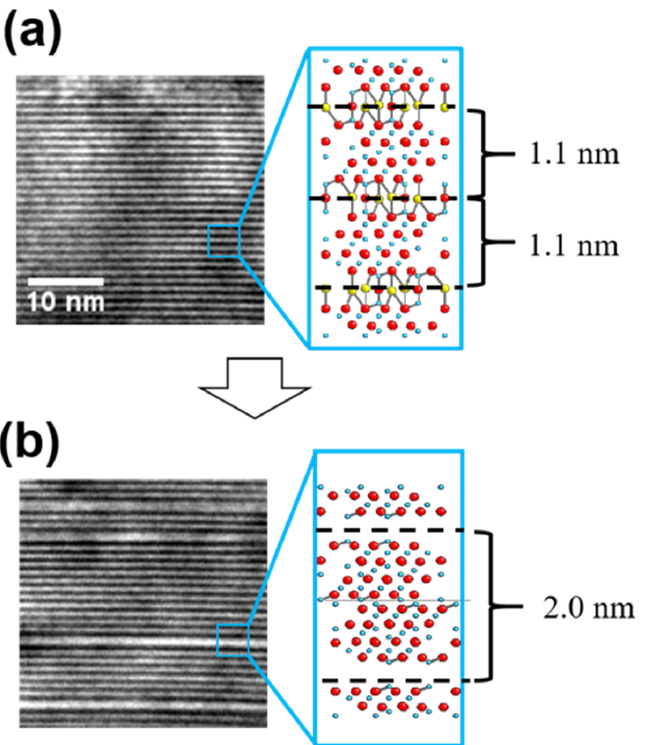
Figure 2. BF-TEM images and their corresponding atomic structures for ( a ) pristine and ( b ) faulted Na-β″-alumina in the of (cid:1)112(cid:4)0(cid:6) viewing